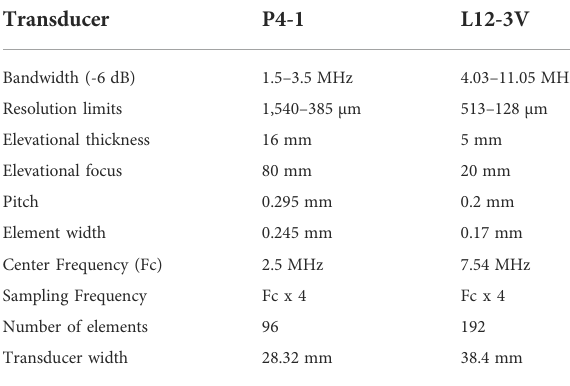
TABLE1ListofrelevanttransducerparametersoftheconventionalUS